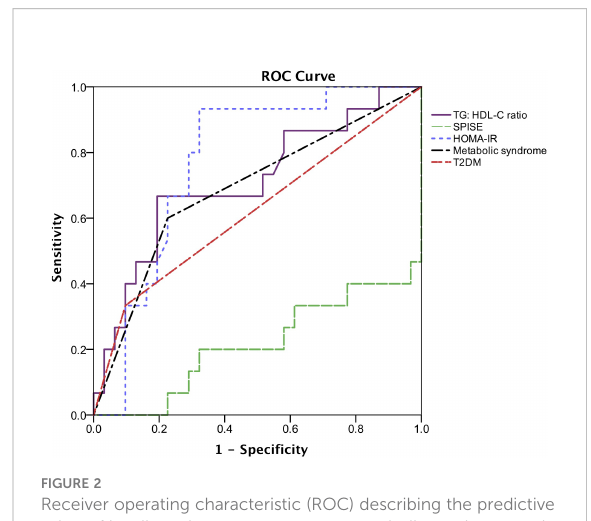
FIGURE 2 Receiver operating characteristic (ROC) describing the predictive value of insulin resistance parameters, metabolic syndrome and T2DM for the presence of liver fi brosis. The area under the ROC curve (AUC) of TG: HDL-C ratio is 0.71 (95% CI: 0.54-0.88, p = 0.022), SPISE is 0.22 (95% CI: 0.06-0.37, p = 0.002), HOMA-IR is 0.77 (95% CI: 0.63-0.91, p = 0.003), metabolic syndrome is 0.704 (95% CI: 0.54-0.87, p = 0.026) and T2DM is 0.62 (95% CI: 0.44-0.80, p =